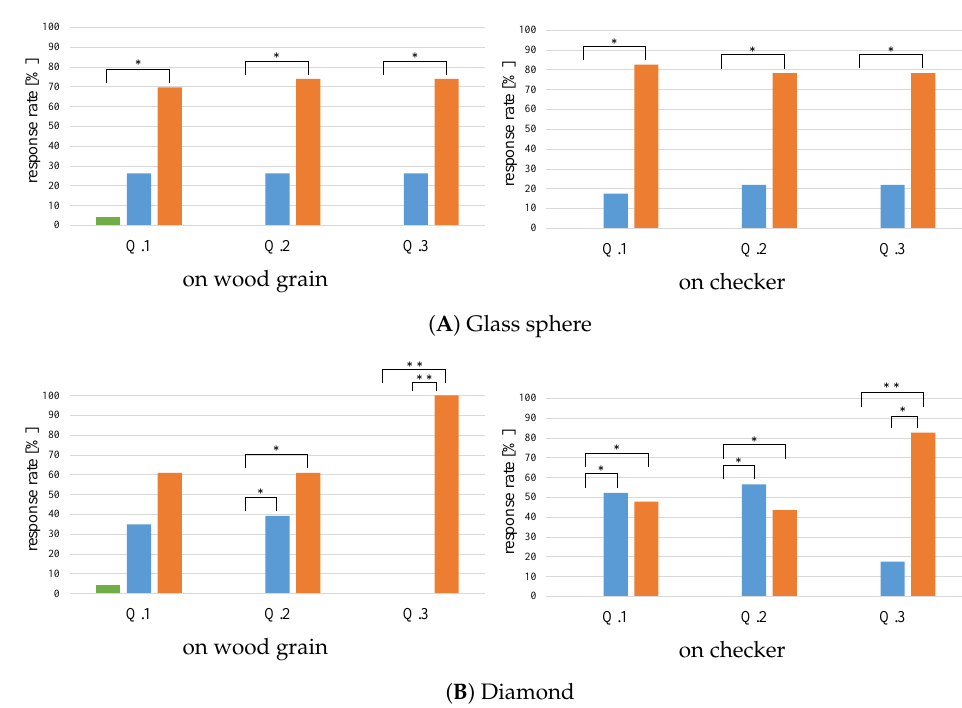
Figure 4. Results of the preliminary